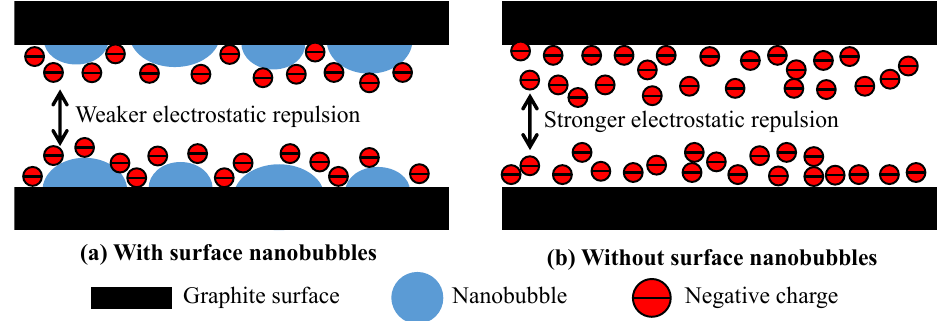
Figure 8. Illustration of surface nanobubbles reducing electrostatic repulsion between graphite.